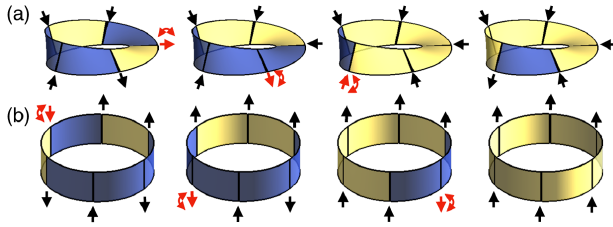
FIG. 2. Orientability as a Z 2 gauge charge. Two discretized ribbons: a Möbius strip (a) and a cylinder (b). The arrows indicate the orientation of the b i vectors, and the plaquettes ’ color the sign of η i;i on each link yellow η i;i ¼ þ and blue η i;i ¼ − 1 . þ 1 þ 1 þ 1